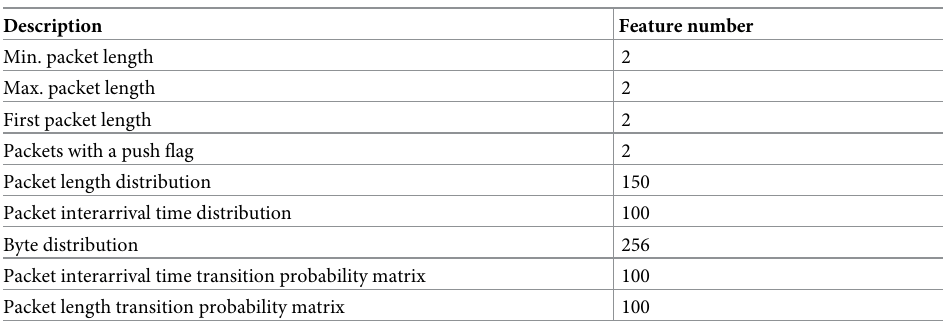
Table 2. Statistical